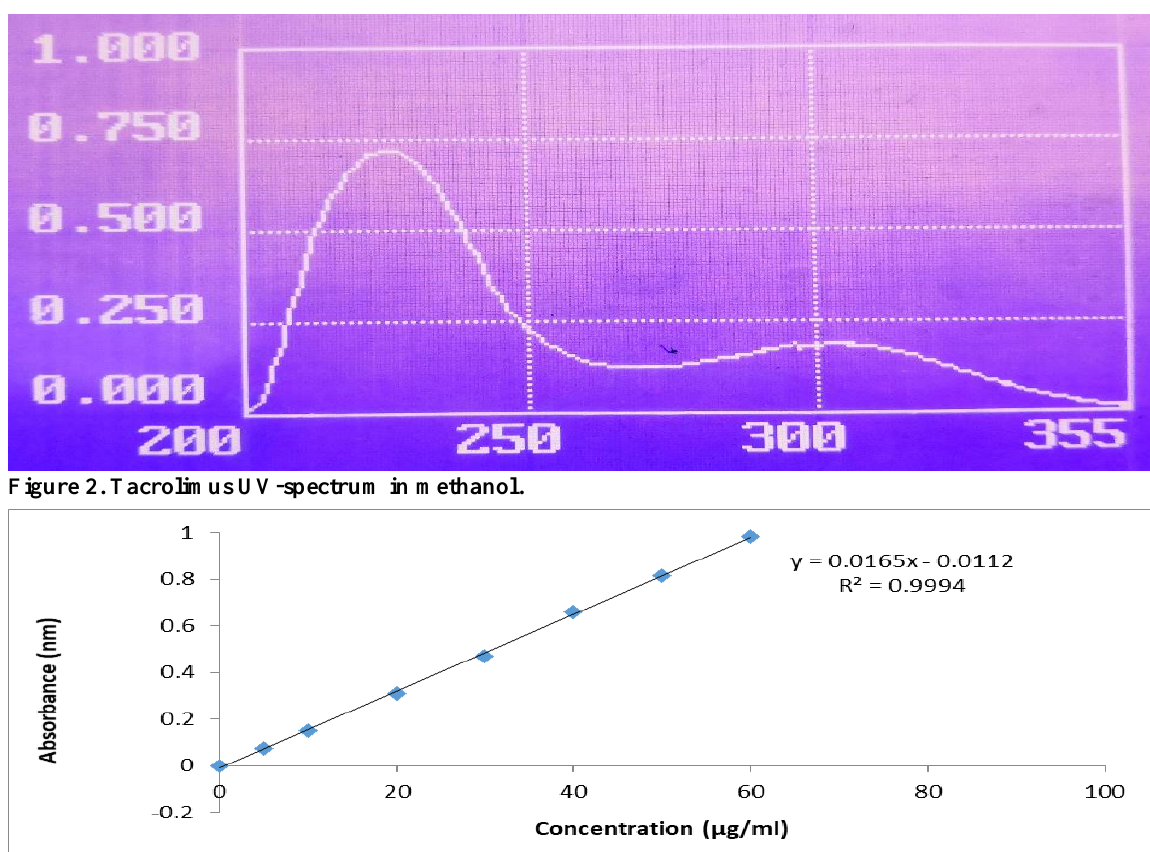
Figure 3. Tacrolimus UV calibration curve in